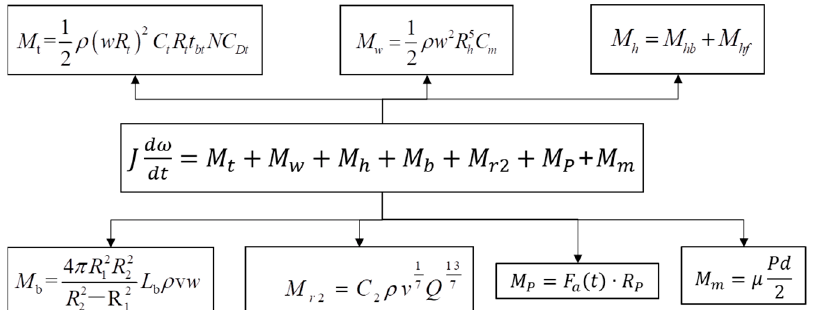
Figure 2. Mathematical model of mechanical turbine flowmeter operation.